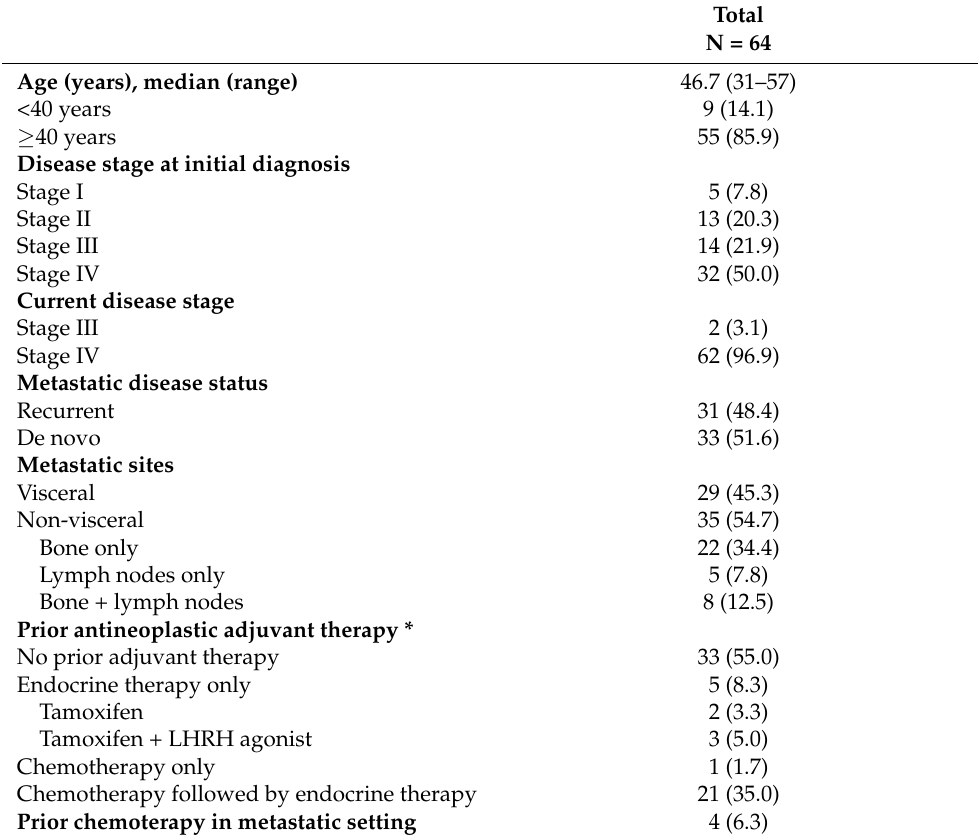
Table 1. Baseline patient and disease characteristics. All data are presented as frequencies (N (%)) unless